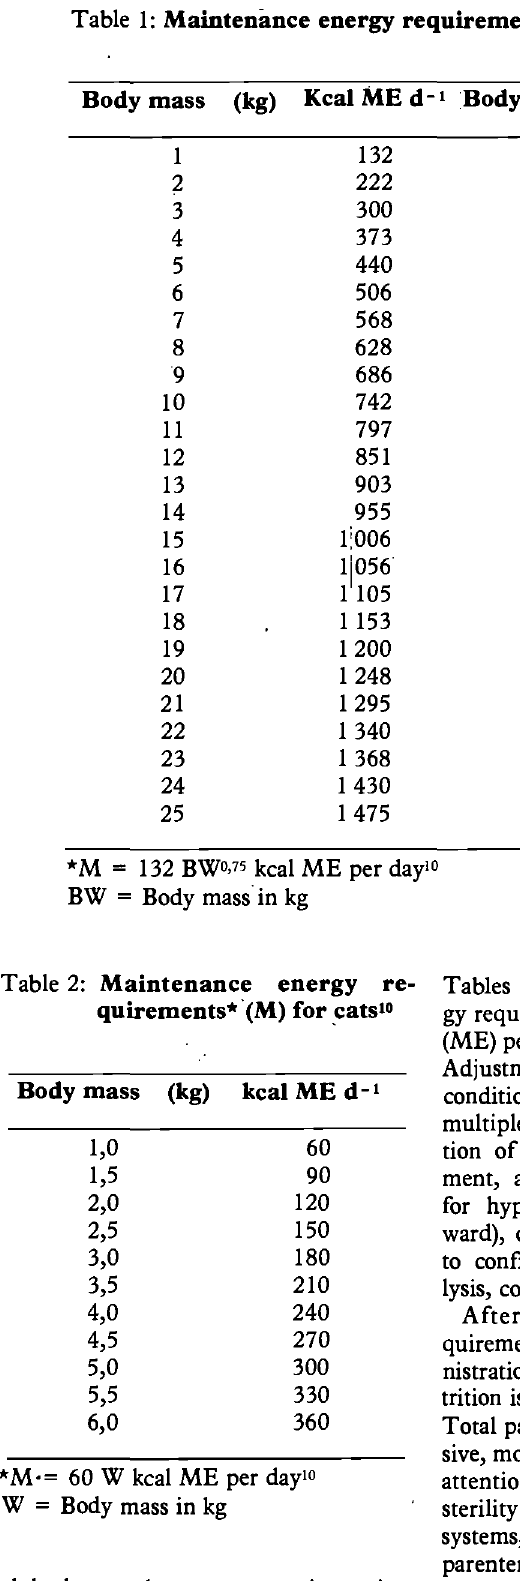
Table 1: Maintenance energy requirements* (M) for dogs lO